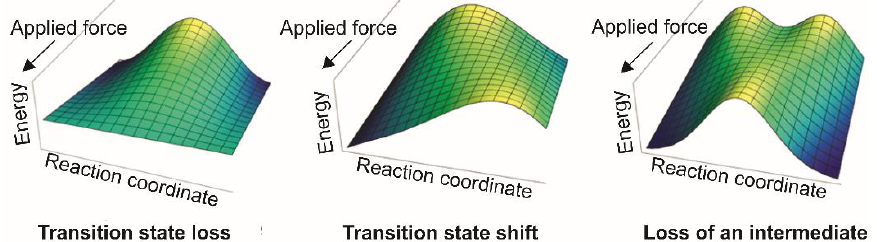
Figure 6. Upon the application of mechanical forces to mechanophores, examples of possible modifications of the ring opening pathways are the loss of the transition state (left), a shift in the transition state (center), and the loss of a reaction intermediate (right). Figure adapted with permission from A. G. Roessler and P. M. Zimmerman, “Examining the Ways to Bend and Break Reaction Path ways Using Mechanochemistry .” J. Phys. Chem. C , 122 (12), 6996 – 7004. Copyright 2018. American Chemical Society.